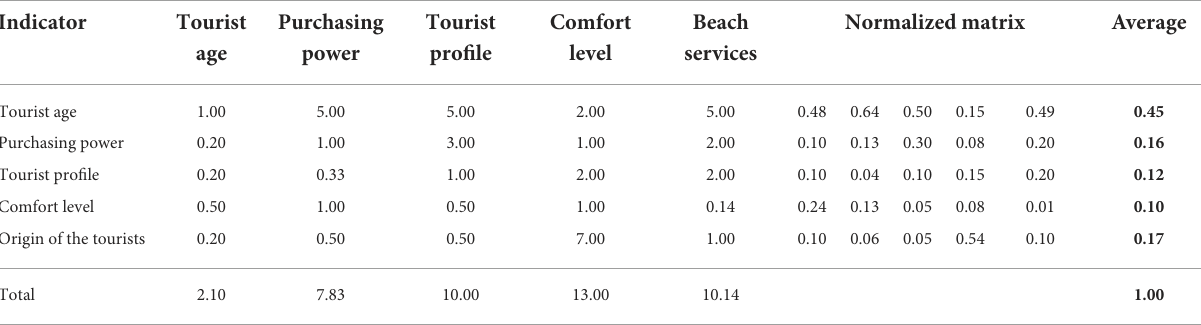
TABLE 2 Matrix containing the AHP evaluation process to obtain the weights associated to the exposure components from the survey with a single stakeholder as an example. Pair wise comparison matrix (Exposure)